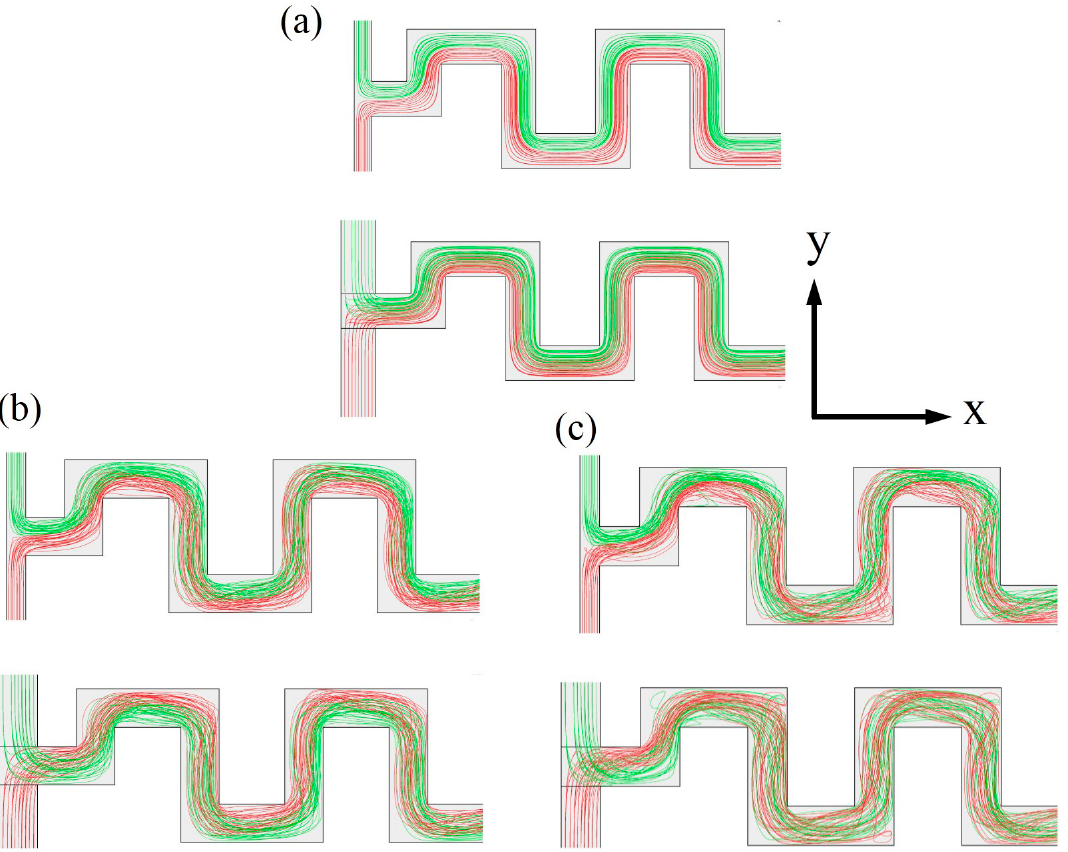
Figure 8. Projected streamlines initiated from Inlet 1 and Inlet 2 for the two different serpentine micromixers: ( a ) Re = 0.1; ( b ) Re = 30; and ( c ) Re = 90